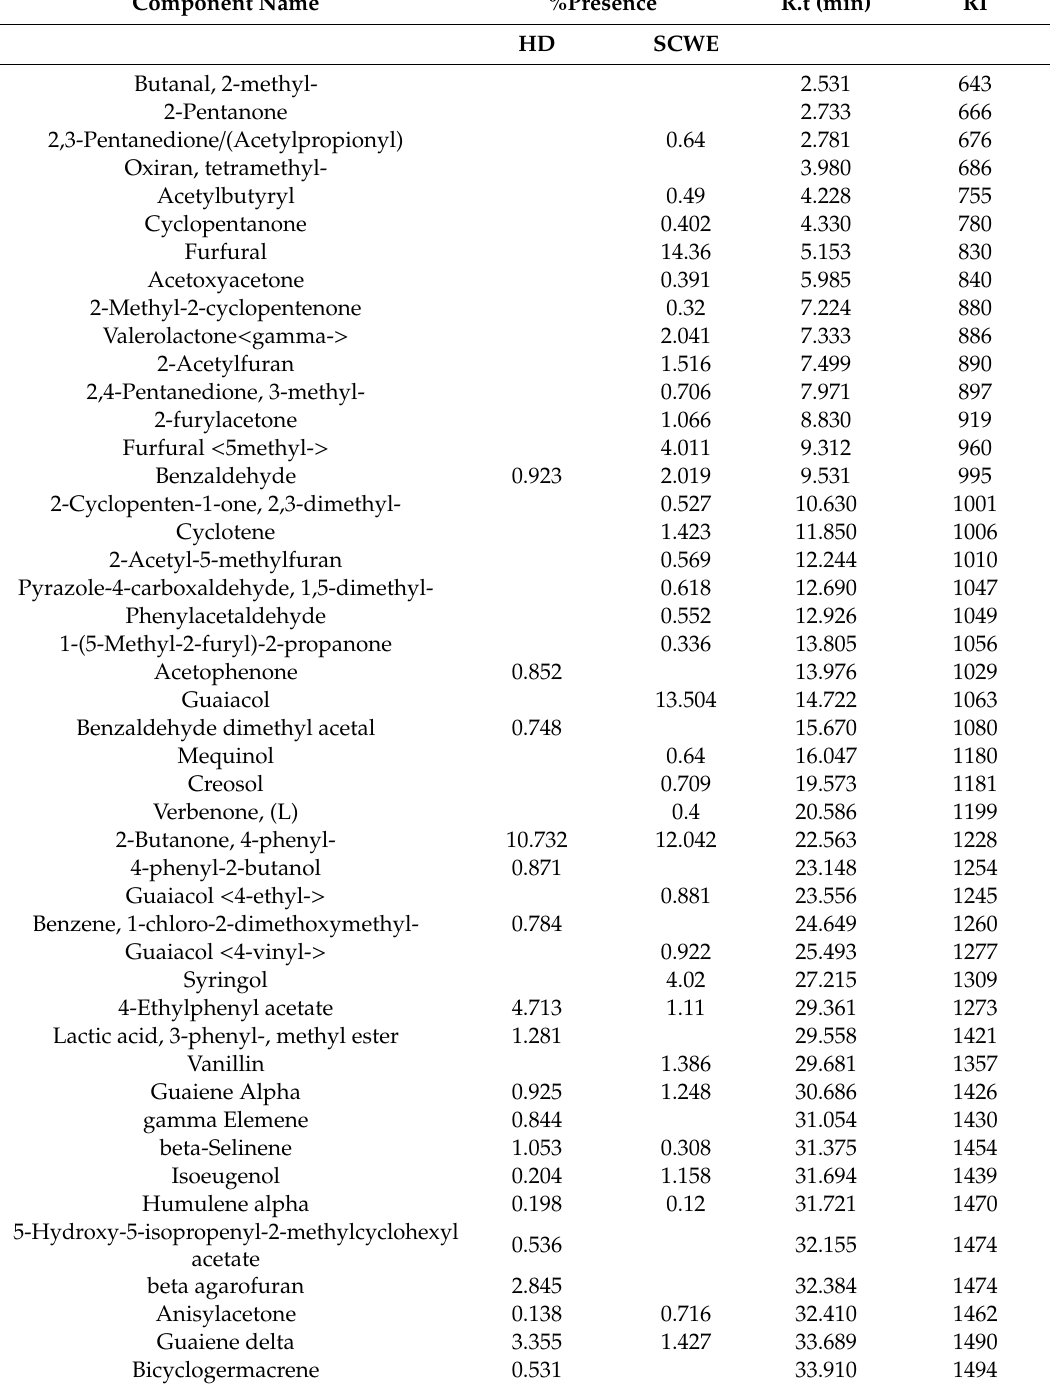
Table 4. Chemical composition of essential oil from Aquilaria malaccensis ’